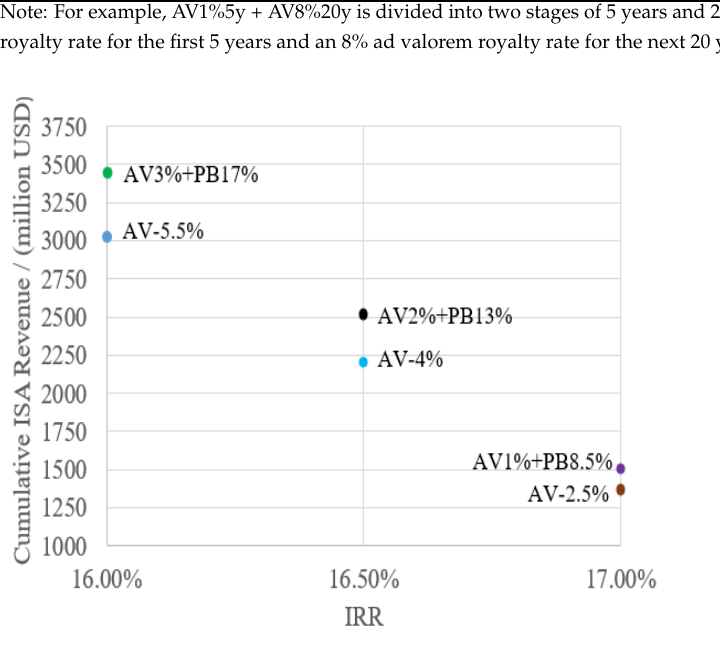
Figure 9. IRR and cumulative ISA revenue with different payment